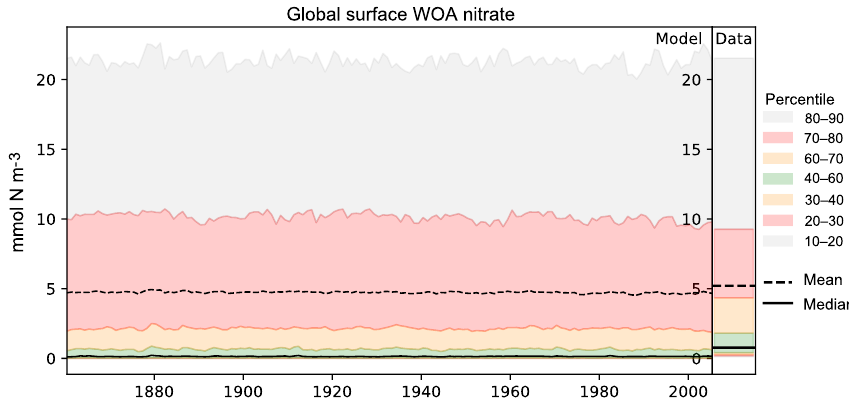
Figure 4. A plot produced by the time series package. The figure shows the time developers of many metrics at once: the mean, median, and several percentile ranges of the observational data and the model data. In this case, the model data are the global surface mean nitrate in HadGEM2-ES in the historical simulation.